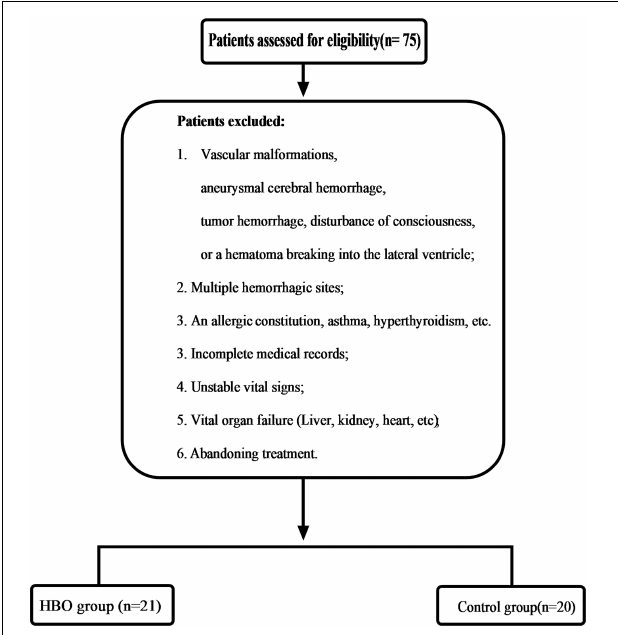
FIGURE 1 | A flow chart for the identification process of eligible